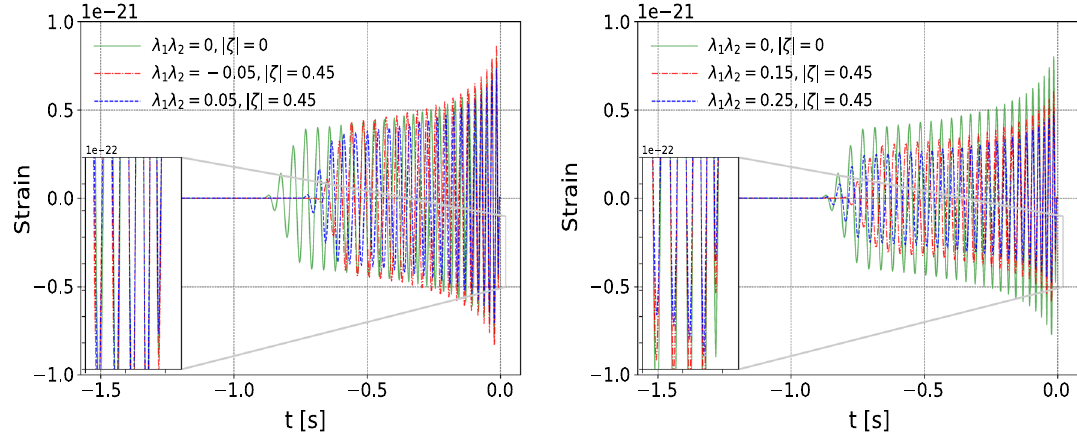
Fig. 2 The tapered LOC gravitational waveforms for BH binaries with different charges. The rest parameters of these waveforms are the same, i.e., the detector-frame masses are m 1 = m 2 = 30M (cid:7) , the luminosity distanceis d L = 540Mpc,theinclinationangleis θ jn = 0.Thelowcut- off frequency is f lo w = 20 Hz. The green solid line represents the case